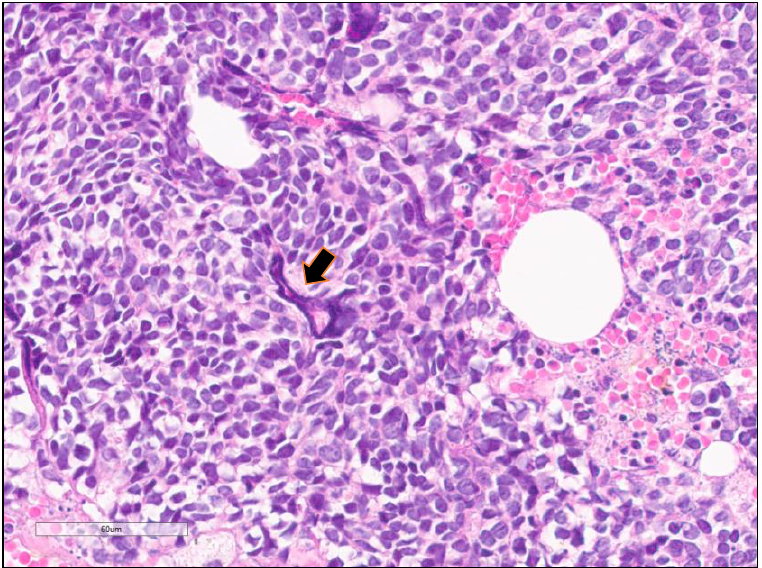
Figure 4. Azzopardi phenomenon. High magnification showing Small cell lung carcinoma (SCLC) with basophilic nuclear debris encrustation of the blood vessel wall (arrow).